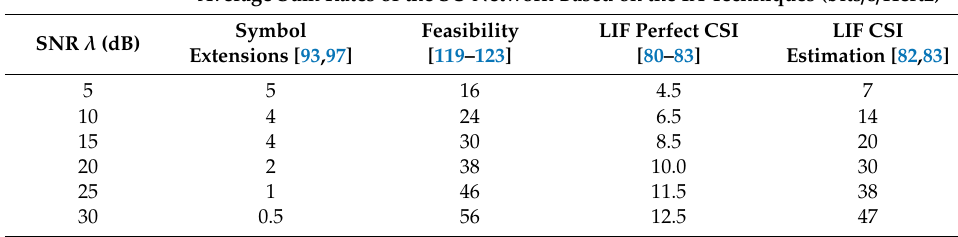
Table 6. Average sum rates against typical SNR values for the second paradigm with SWF for the multiple SU MIMO link [80–83,93,97,119–123]. Average Sum Rates of the SU Network Based on the IA Techniques (bits / s /